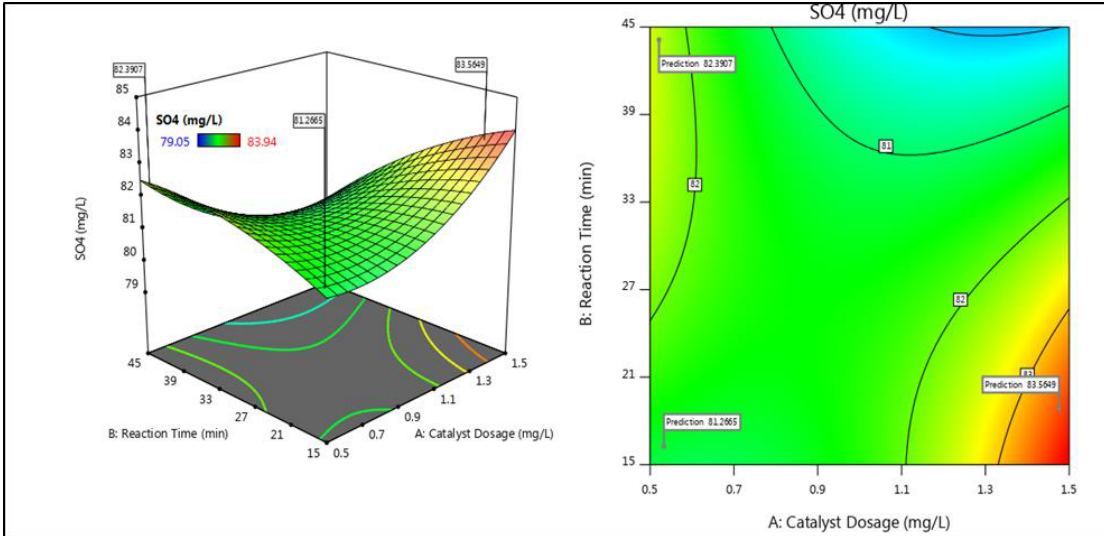
Figure 7. 2D and 3D plots representing the cross factor interactive e ff ects of catalyst dosage and reaction time (AB) on SO 4 2 − removal by TiO 2